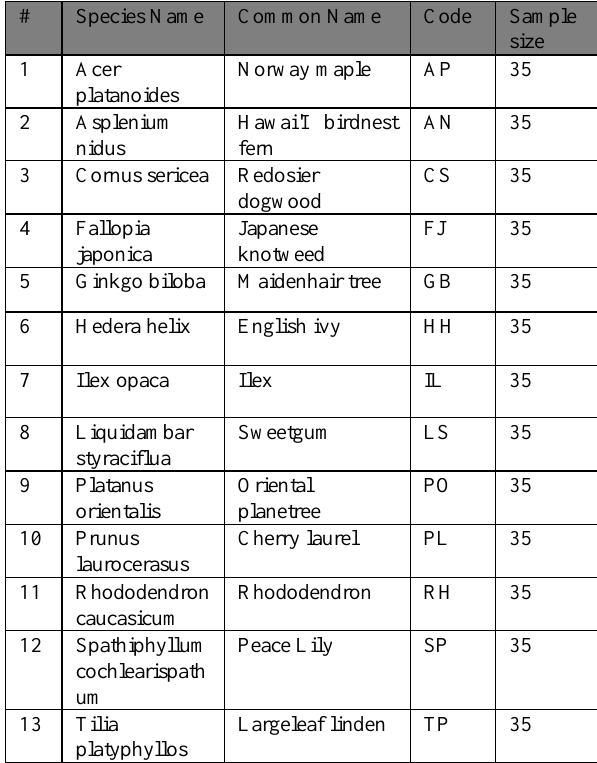
Table 1. Thirteen Plant Species Common Name, Code, And the Number of Leaves Per Species Measured Using A Laboratory Spectroradiometer (2.5 Μm-14 Μm ).